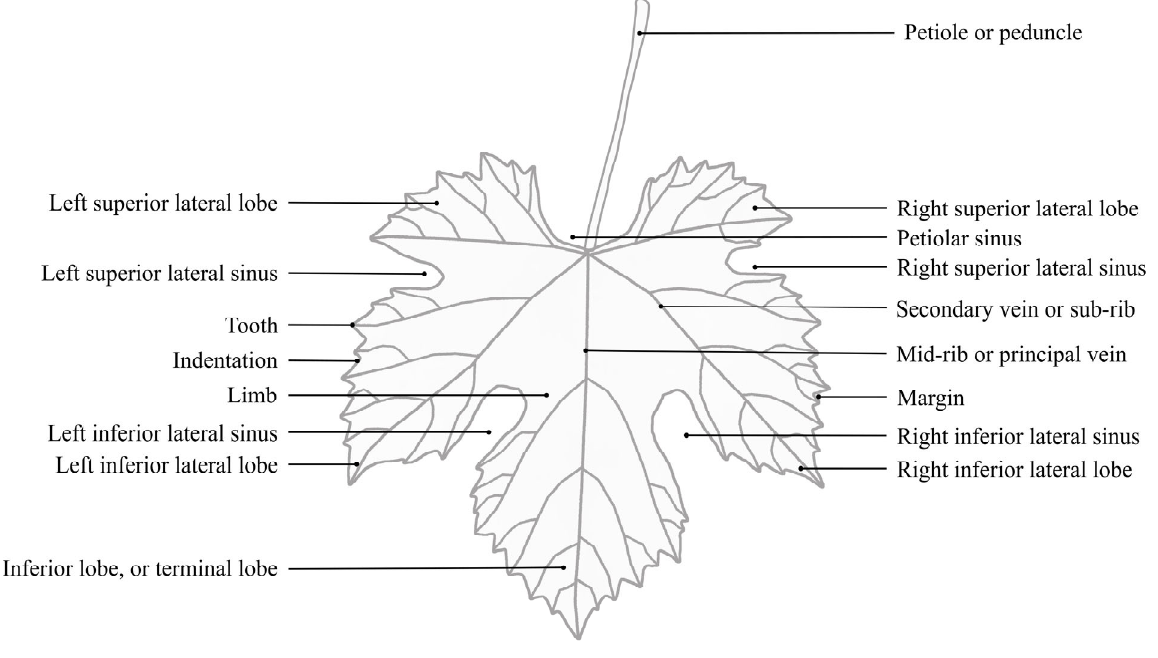
Figure 1. Grapevine leaf (according to Mazade [9]).